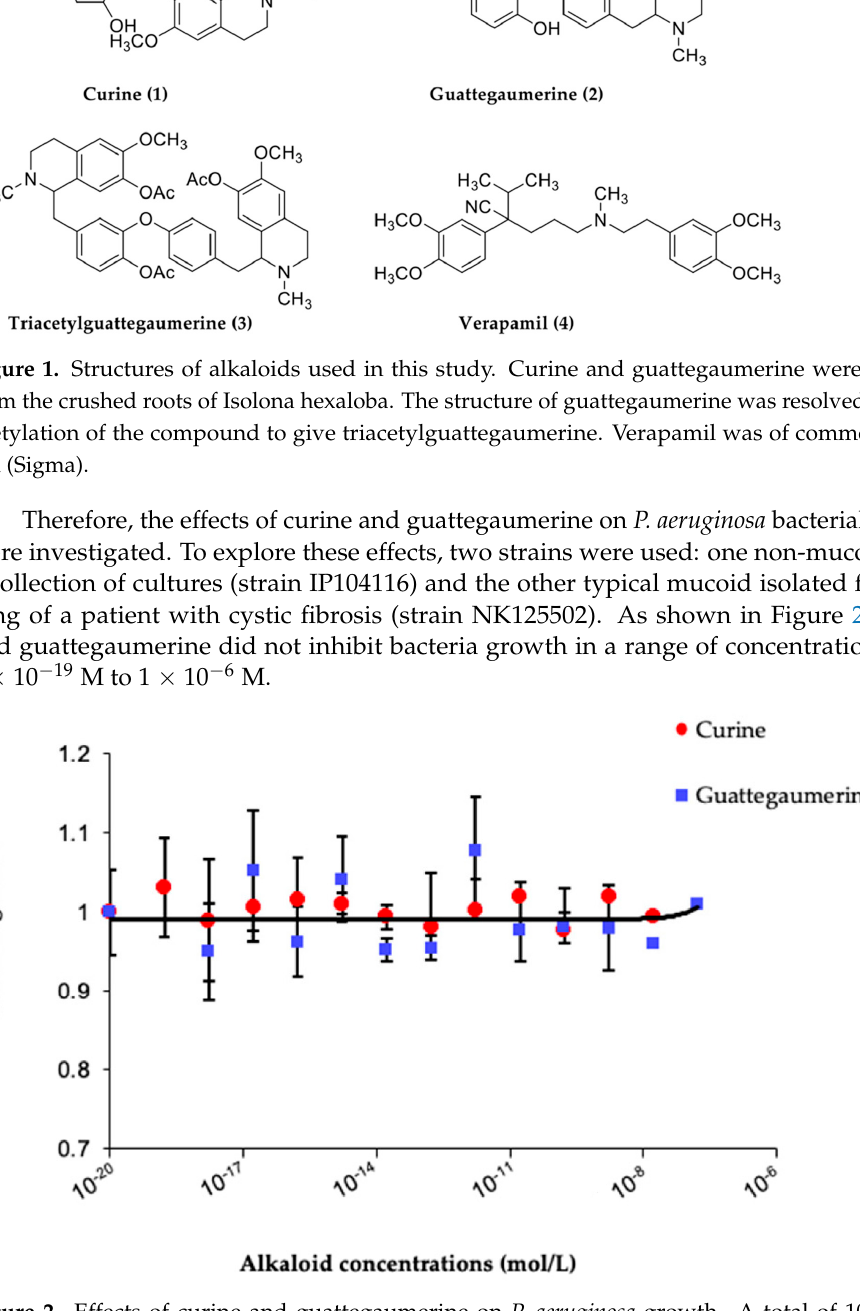
Figure 2. Effects of curine and guattegaumerine on P. aeruginosa growth. A total of 100 µ L LB medium containing 1 × 10 5 bacteria of strain IP104116 and increasing concentrations of curine or guattegaumerine were added in each well of 96-well plates. After 24 h of incubation at 37 ◦ C in a wet chamber, growth was estimated by measuring the absorbance at 595 nm and was compared to the control without curine or guattegaumerine and plotted against concentration in alkaloids in the corresponding well. Experiments were repeated at least four times for each strain of P. aeruginosa used in this